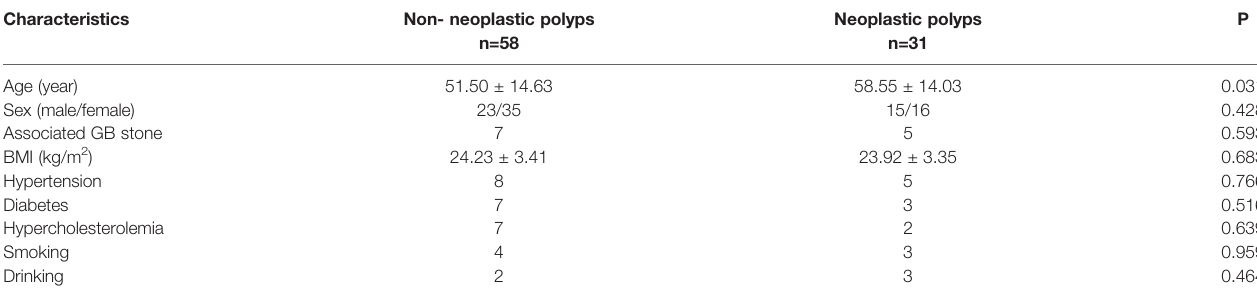
TABLE 1 | Patient